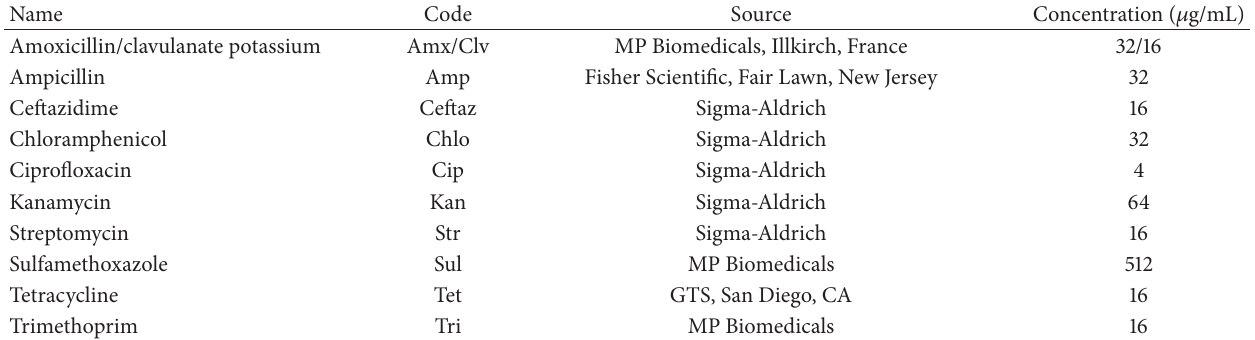
Table 1: Antibiotic concentration tested against E. coli from surface waters in northern